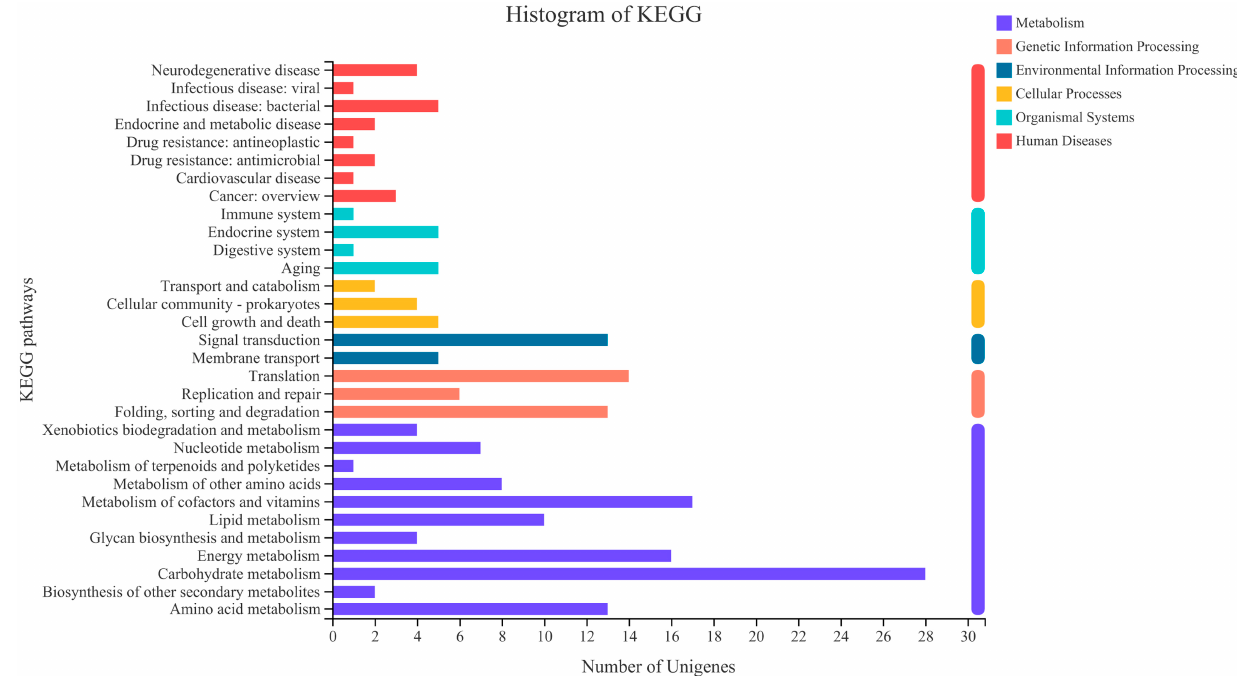
Figure 5. Comparative transcriptomic analyses of A. muciniphila cultured with MGO for 6 days. KEGG pathway enrichment analysis of DEGs. The horizontal coordinates represent the KEGG pathway name, and the vertical coordinates represent the number of transcript/metabolite unigenes.